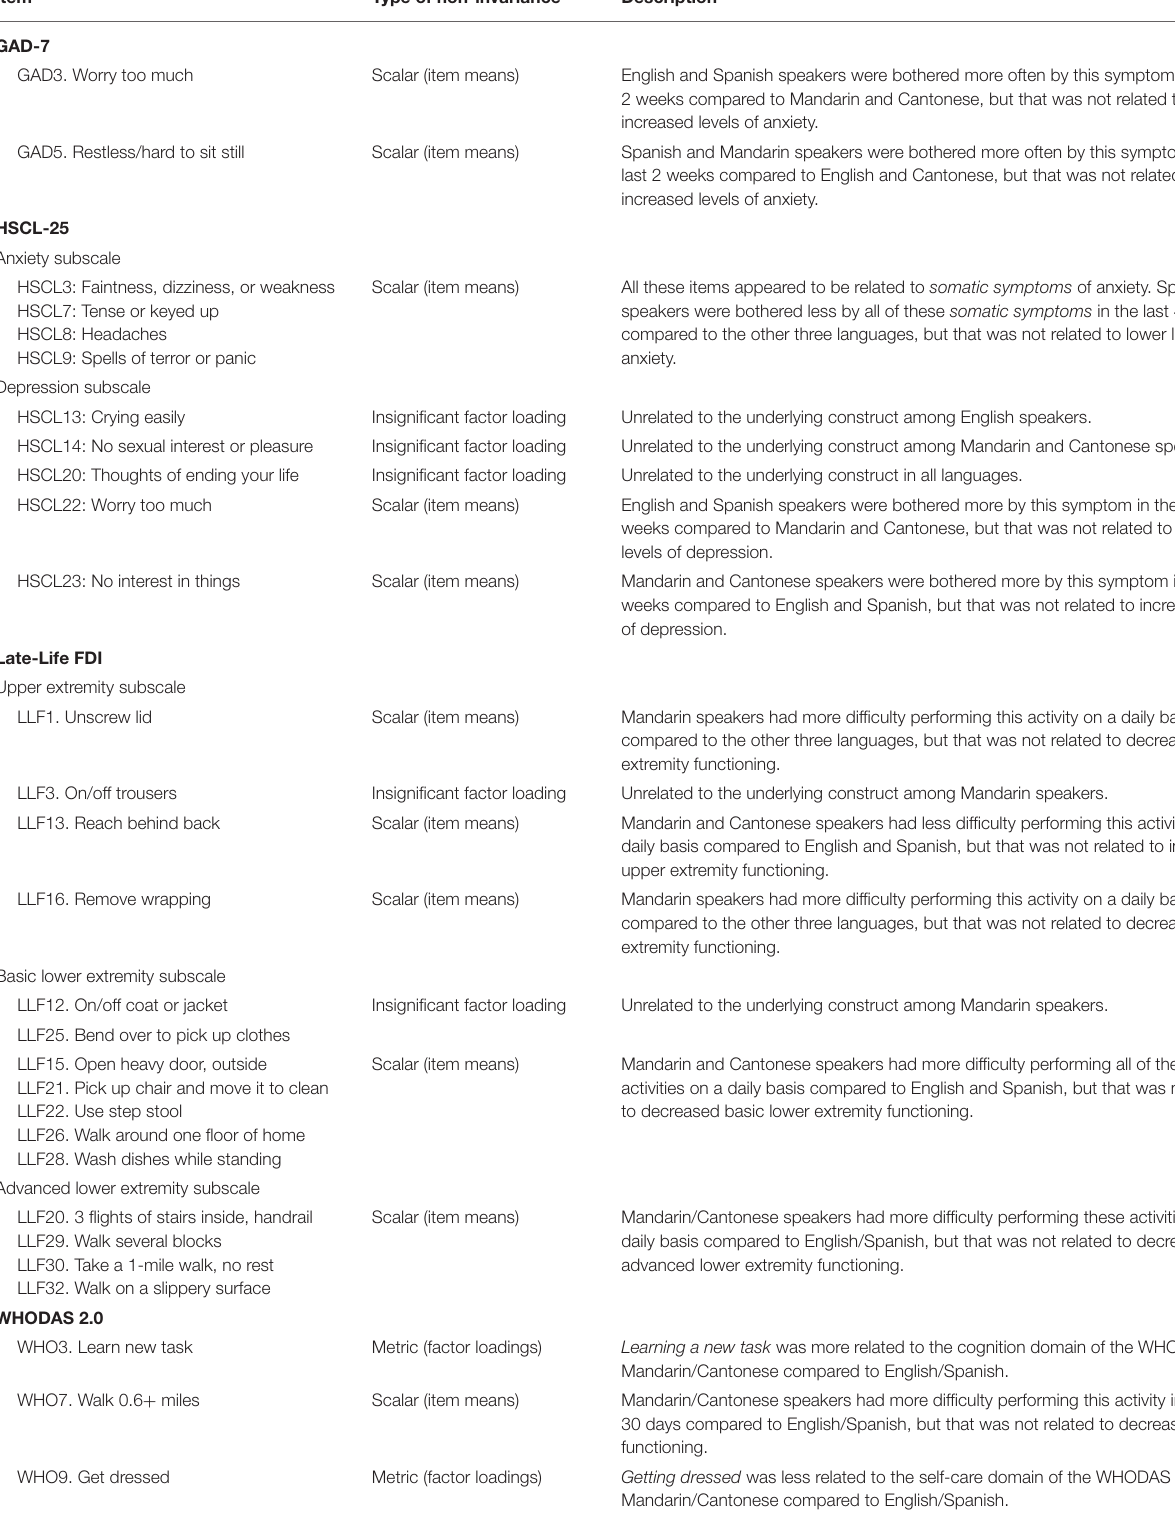
TABLE 3 | Summary of non-invariant